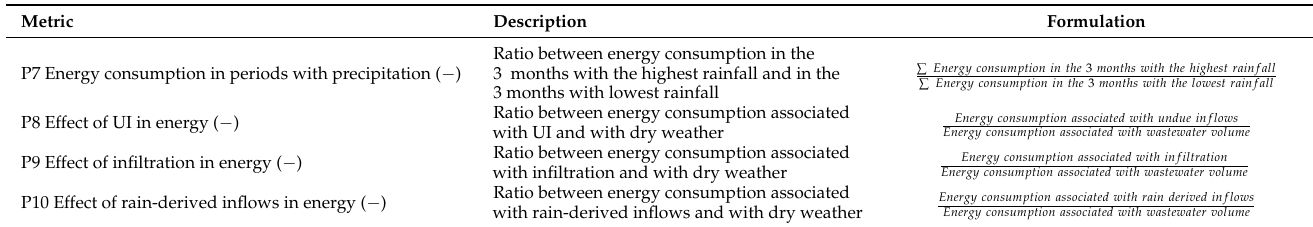
Table A2. National characterization for the evaluation of the W-E-G nexus for 2015.